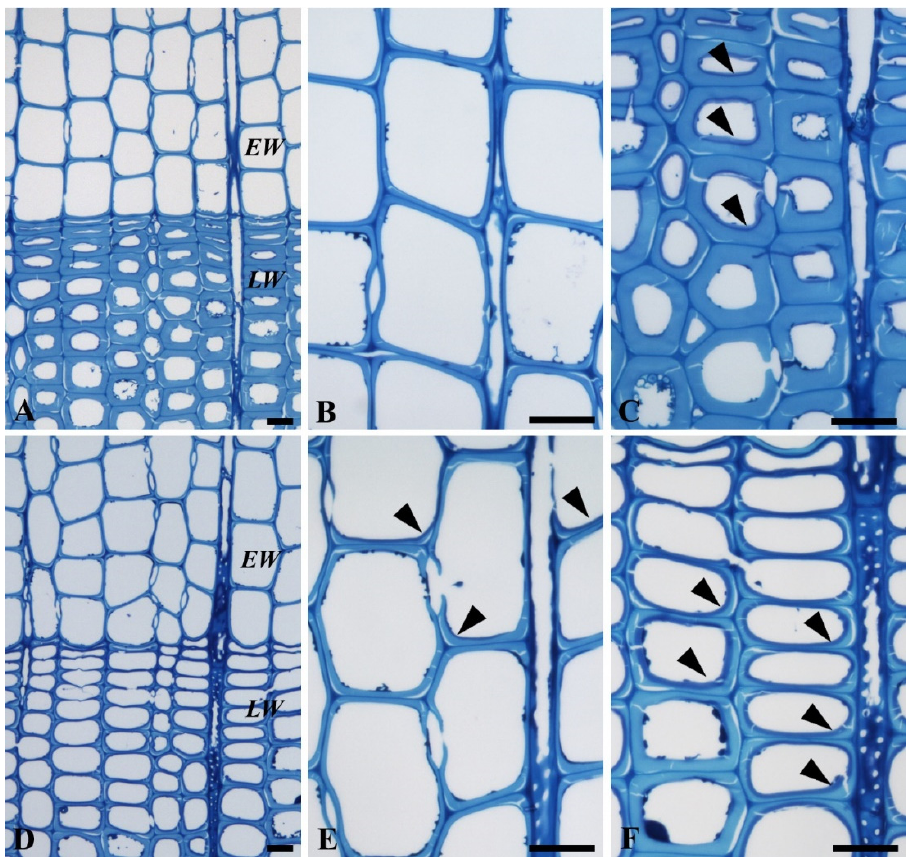
Figure 7. LM observations of spruce wood decayed by P. ostreatus and T. versicolor . ( A – C ) Decay by P. ostreatus showing early stages of decay in both earlywood ( EW ; A , B ) and latewood ( LW , C ). Note formation of decay zone (arrowheads) in some LW fibers ( C ). ( D – F ) Decay by T. versicolor showing more advanced stages of decay than P. ostreatus ( A ), particularly LW regions ( F ). Note formation of decay zones (arrowheads) in EW ( E ) and LW fibers ( F ). Scale bars: 20 µm.